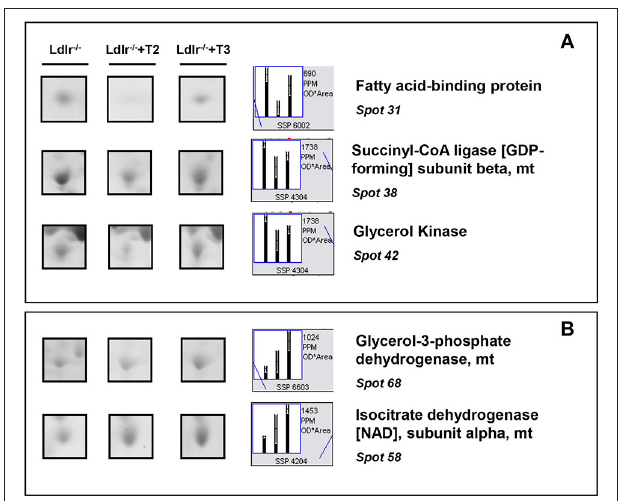
FIGURE 5 | Iodothyronine specific effects on differential expression in liver of Ldlr − / − mice. (A) Representative T2 specific affected proteins. (B) Representative T3 specific affected proteins. Results are expressed as arbitrary units (means ± SD; n = 4) ( p <